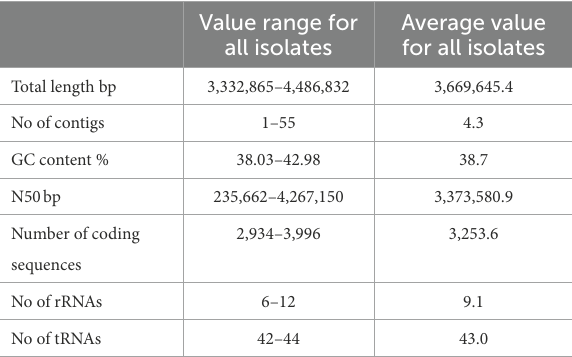
TABLE 2 Average general characteristics of the hybrid assembly of isolates sequenced in this study. Value range for all isolates